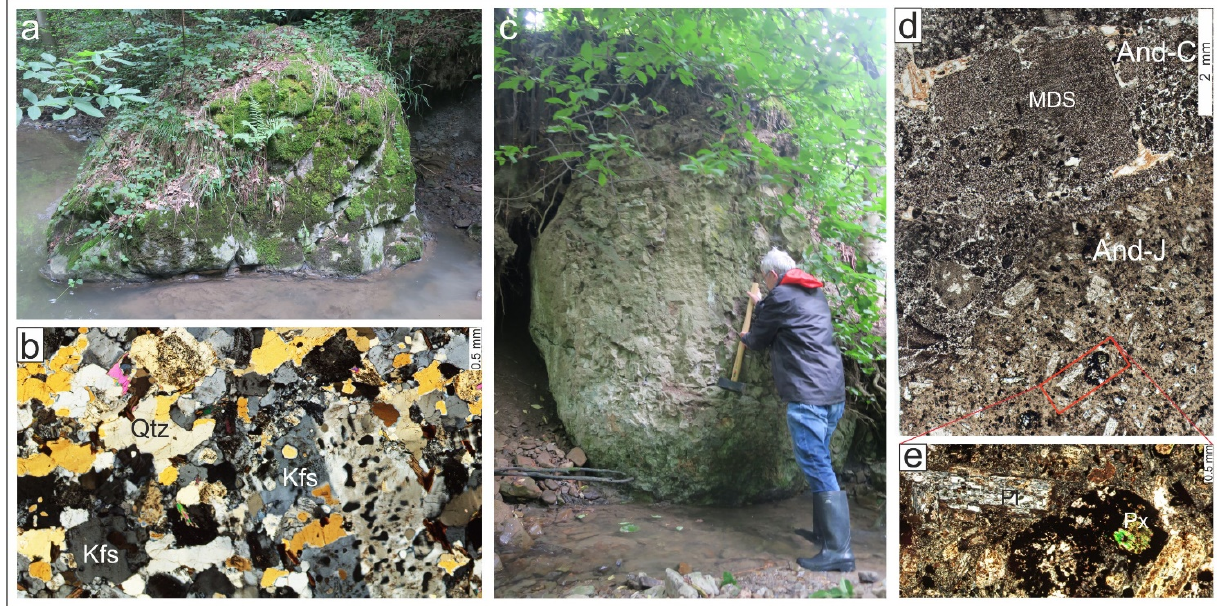
Figure 2. Photographs of the exotic blocks from Pluskawka Stream, with their microstructures: ( a ) Pl 2 microgranitoid block, in situ within the marl (exposure in Pluskawka Stream); ( b ) microstructure of the granite, composed of quartz (Qtz), K-feldspar (Kfs), sericitized plagioclase, muscovite and biotite; ( c ) andesitic (And) exotic block (Jan Golonka during sampling for scale), in situ within the marly matrix; ( d ) photomicrograph showing the contact between dark (And-C) and light (And-J) parts of the andesitic block, with mudstone xenoliths (MDS); ( e ) insert showing the remnants of pyroxene (Px) and albitized plagioclase (Pl).